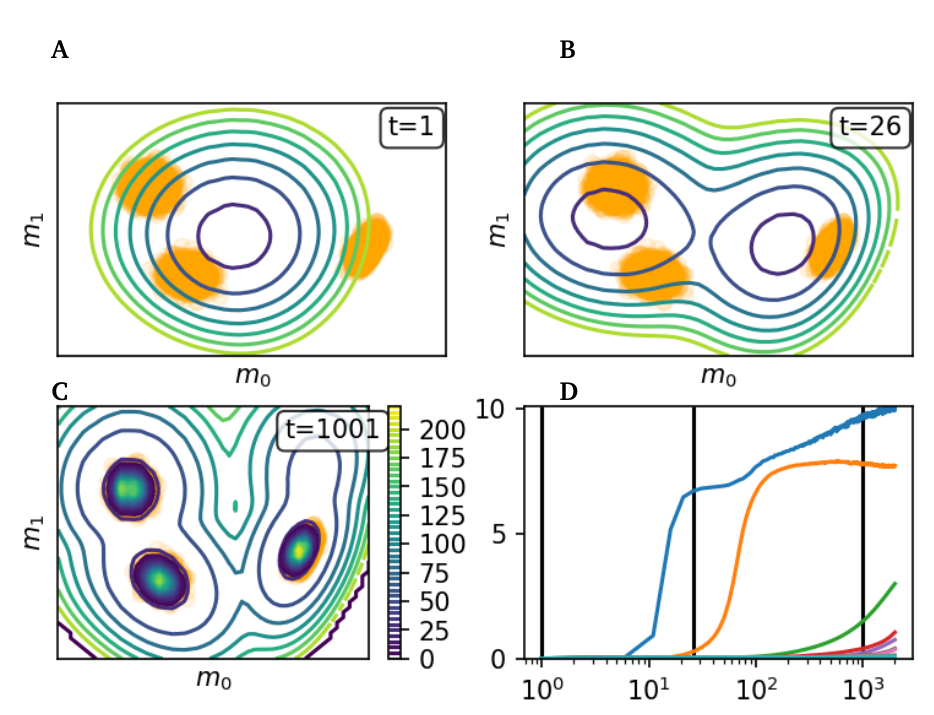
Figure 6: A-C: In orange dots, we show the m of a synthetic dataset of 3 clusters. In a contour map, we show the TMC effective potential Ω reconstructed at different moments of the training of a TMC-RBM ( t refers to the number of updates). At t distribution (in a heatmap), which correctly reflects the density of the three clusters.